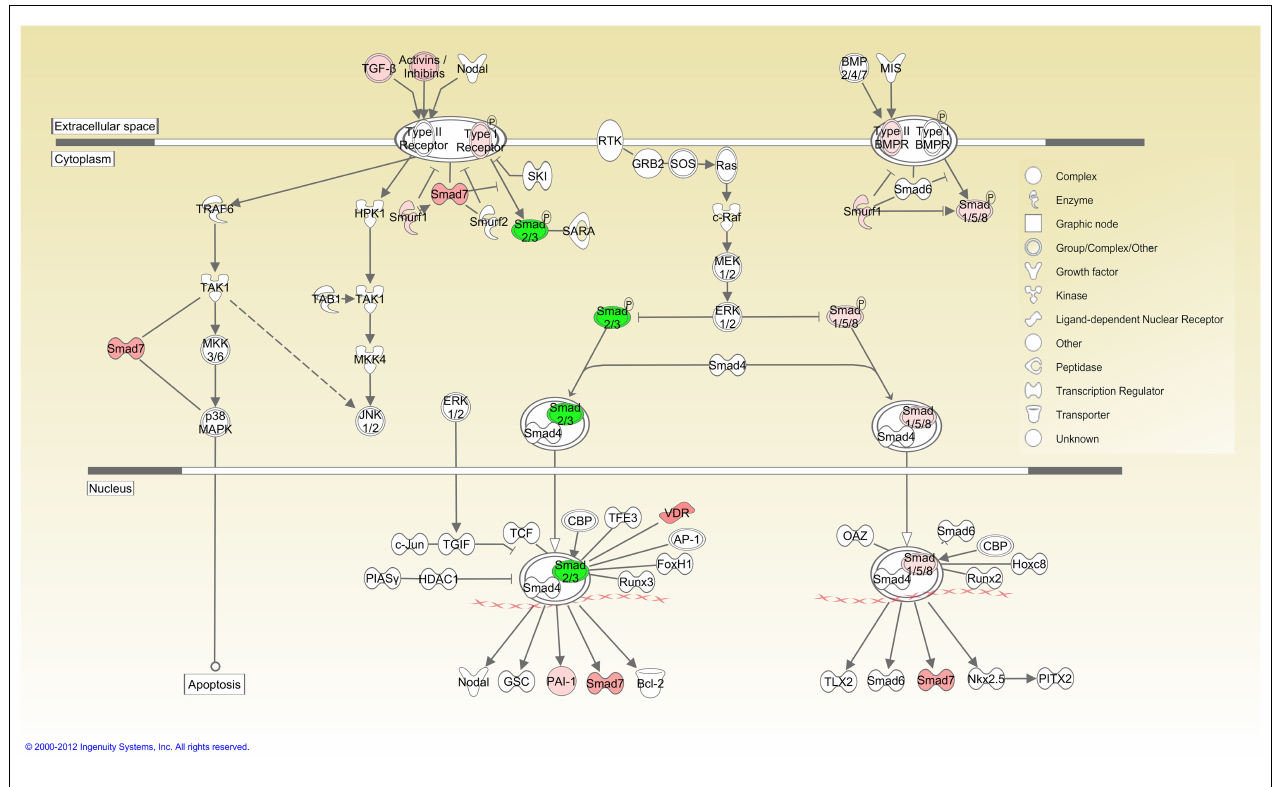
overlapping genes are: TGF β 1 , TGF β 2 , INHBA (activins/inhibins), BMPR2 , SMAD7 , SMURF1 , SMAD 1/5/8 , SMAD2/3 , VDR , and PAI-1. Green color represents downregulated expression, whereas red color represents upregulated expression of genes. Color intensity reflects the level of expression.Types of molecules are annotated in the legend in the